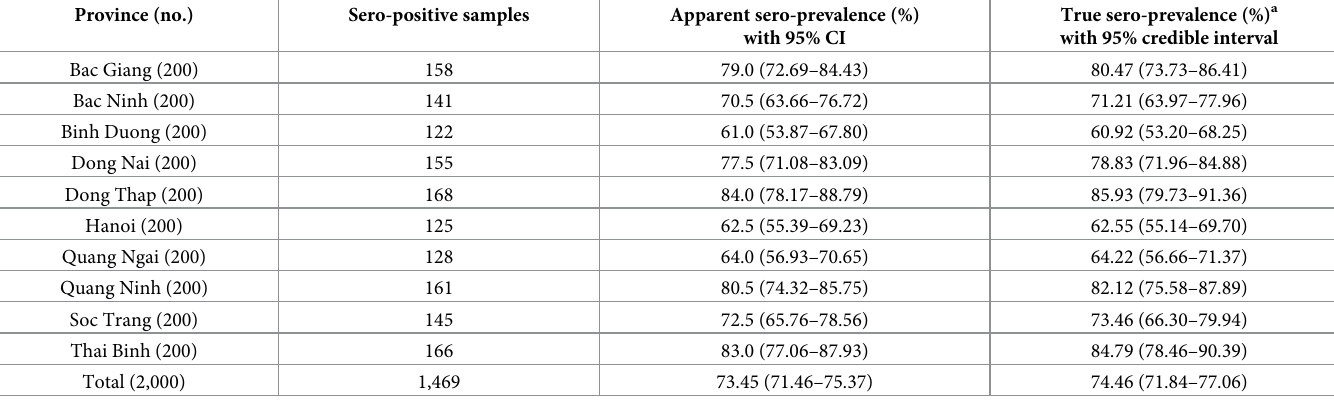
Table 4. Apparent sero-prevalence with 95% CI and true sero-prevalence with 95% credible interval for Japanese encephalitis in pigs in Vietnam. Province